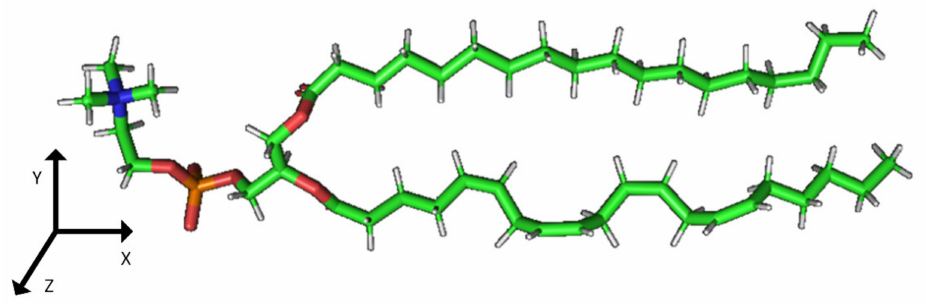
Figure 1. Molecule of 1-palmitoyl-2-oleoyl-sn-glycero-3-phosphatidylcholine (POPC).